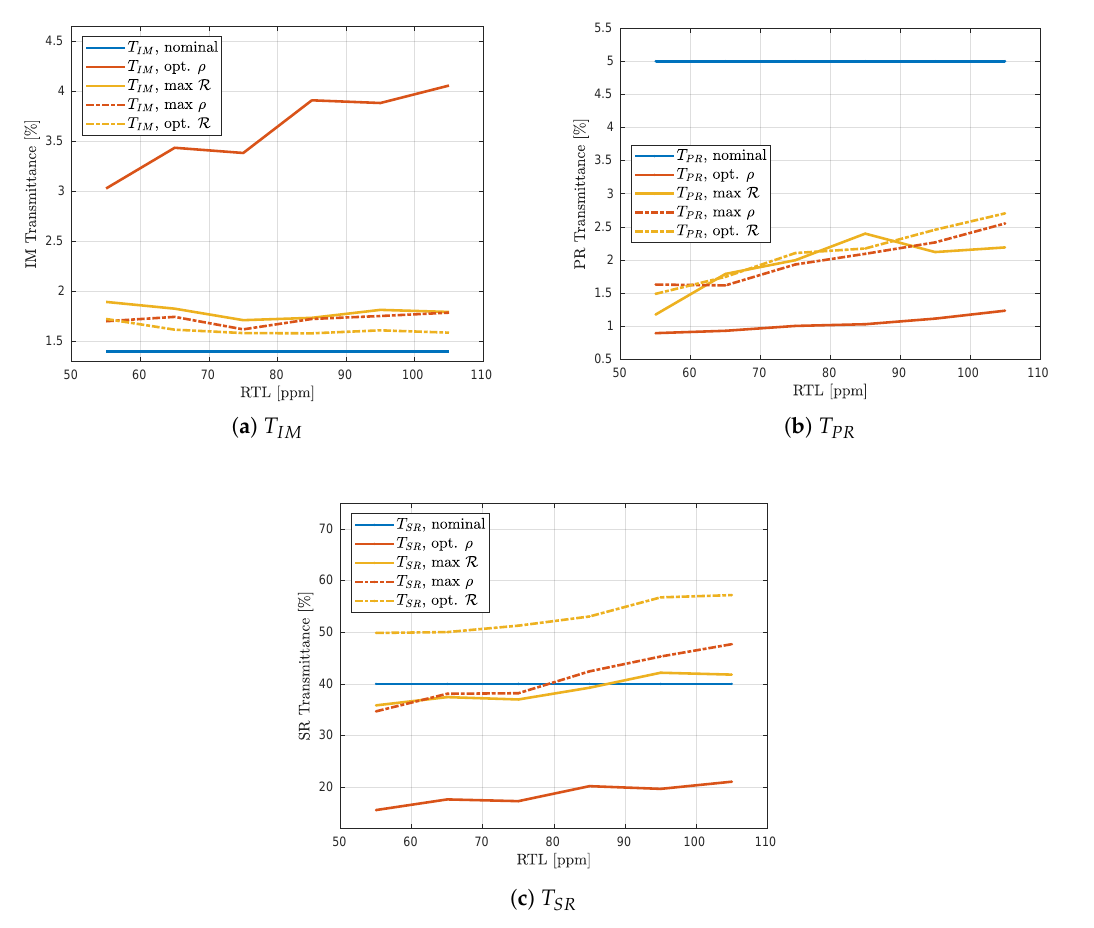
Figure 6. Opt and max configuration transmittances found by the optimization routine. ‘Opt’ corresponds to an optimal primary parameter, while ‘max’ corresponds to a maximum secondary parameter within a predefined budget of the optimal primary parameter found. Nominal configurations that use the currently expected IM, PRM, and SRM transmittances are shown for